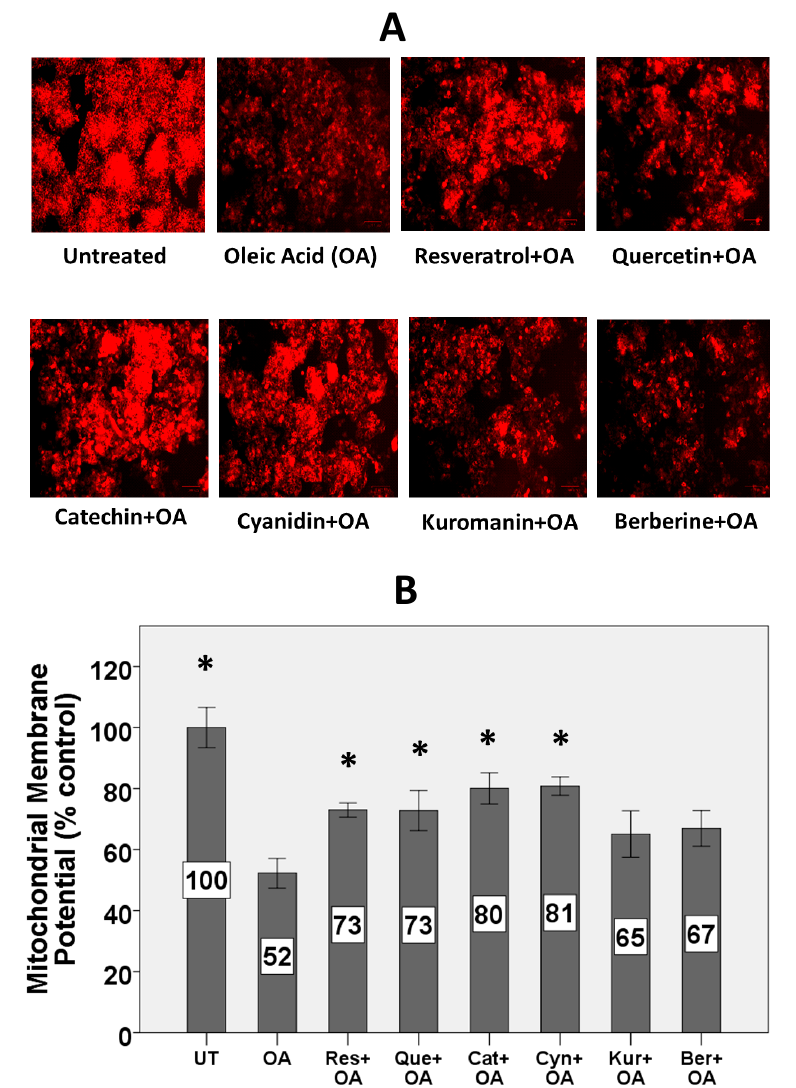
Figure 2. Effect of OA and polyphenols on mitochondrial membrane potential. HepG2 cells were treated with 10 µ M polyphenols for 2 h followed by 1.5 mM OA for 24 h. ( A ) Fluorescence images representing the effect of OA and polyphenols on MMP after TMRE staining. Images at 20x magnification were captured using a ZOE Fluorescent Cell Imager. ( B ) MMP was measured following quantification of TMRE fluorescence using a microplate reader. Untreated cells were set at 100% and data are presented as % of the untreated cells. The Figure represents means ± SEM of three independent experiments with three wells of cells in each experiment. (*) Significantly different from the OA alone condition at p < 0.05.